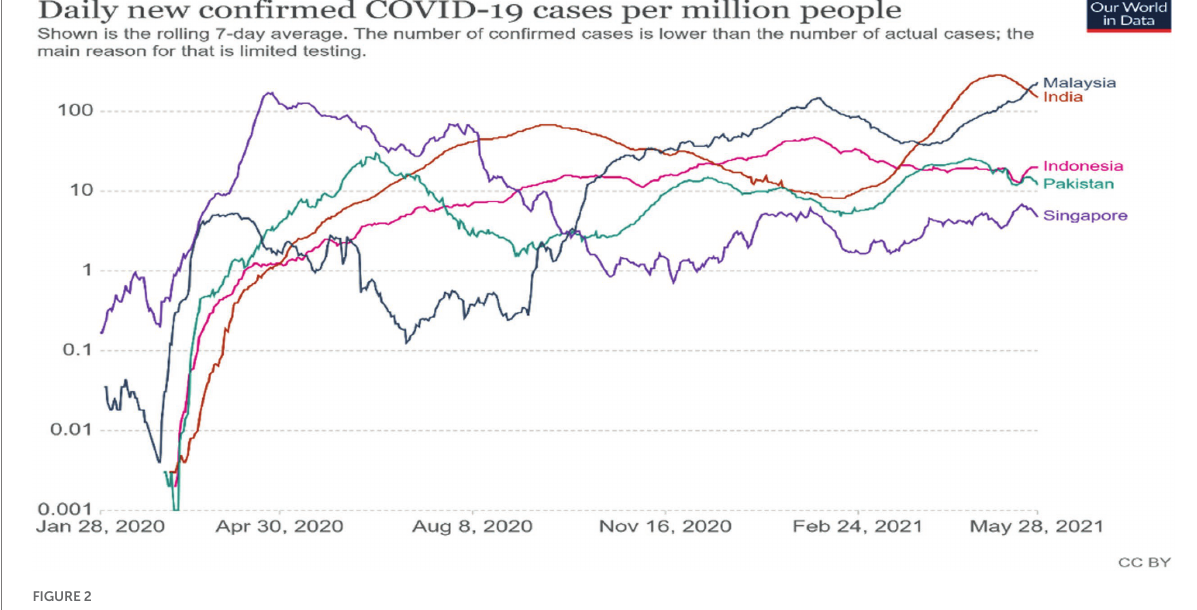
FIGURE 2 Reproduced under CC-BY-4.0. Our World in Data, Data Explorer - Our World in